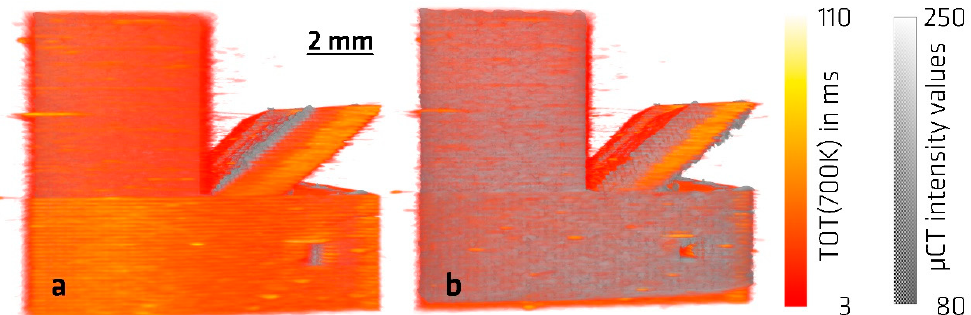
Figure 11. Results of image registration with Euler ( a ) and affine ( b ) transformation.